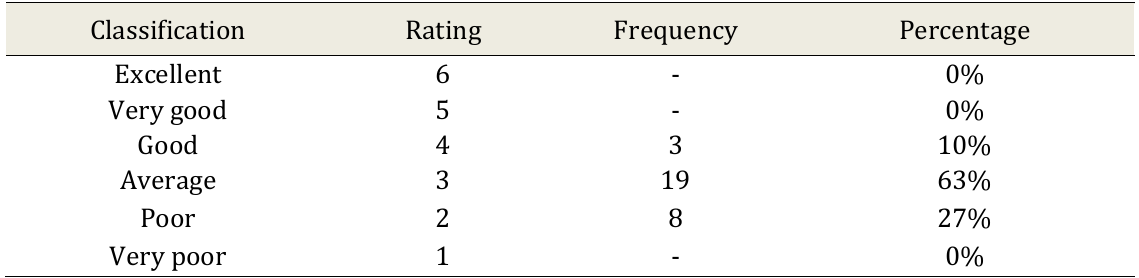
Table 4.22 The Rate Percentage Score of Students' Accuracy in Posttest Result in Control